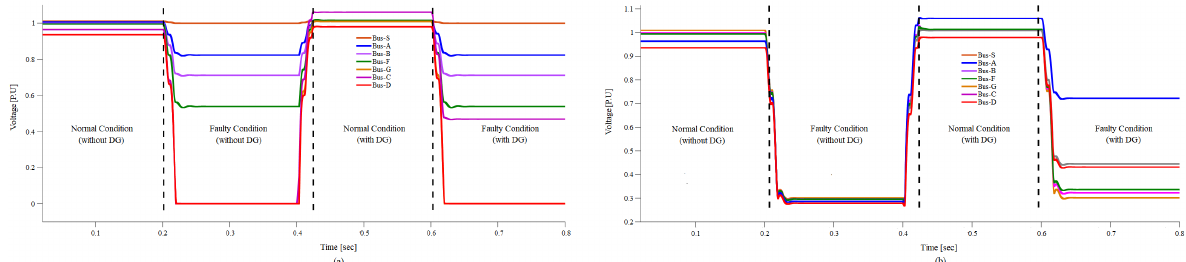
Figure 7. Voltage profile of the simulated system with and without DG under normal and faulty conditions, ( a ) three phase fault (symmetrical) at point F2 (forward), ( b ) single phase fault (unsymmetrical) at point F1